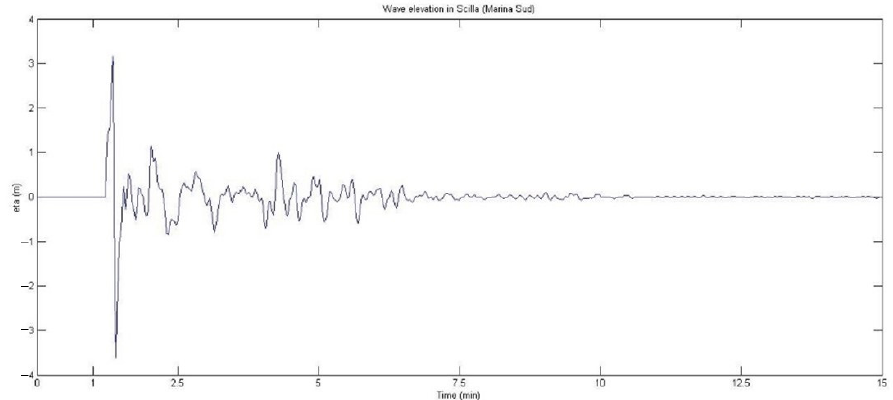
Figure 24. Free surface elevation obtained from the depth-integrated model in Scilla Marina Grande Sud.